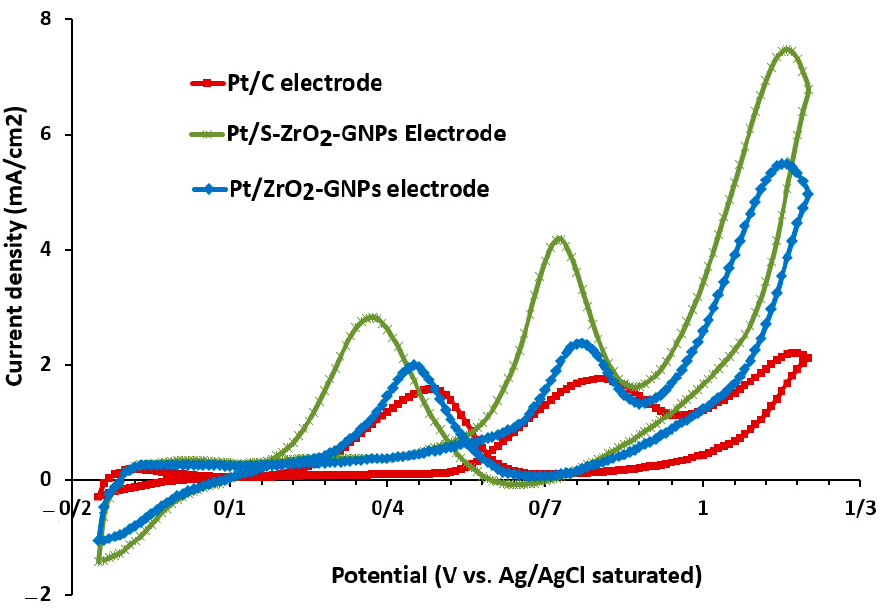
Figure 8. Cyclic voltammograms of ethanol oxidation of Pt/S-ZrO 2 -GNPs, Pt/ZrO 2 -GNP electrodes, trodes, and Pt/C electrode in 0.5 M H 2 SO 4 + 1 M CH 3 CH 2 OH solution scan rate: 50 mV.s − 1 at 25 ◦ C and Pt/C electrode in 0.5 M 𝐻 (cid:2870) 𝑆𝑂 (cid:2872) + 1 M 𝐶𝐻 (cid:2871) 𝐶𝐻 (cid:2870) 𝑂𝐻 solution scan rate: 50 mV.s (cid:2879)(cid:2869) at 25 °C under N 2 under N 2 flux.